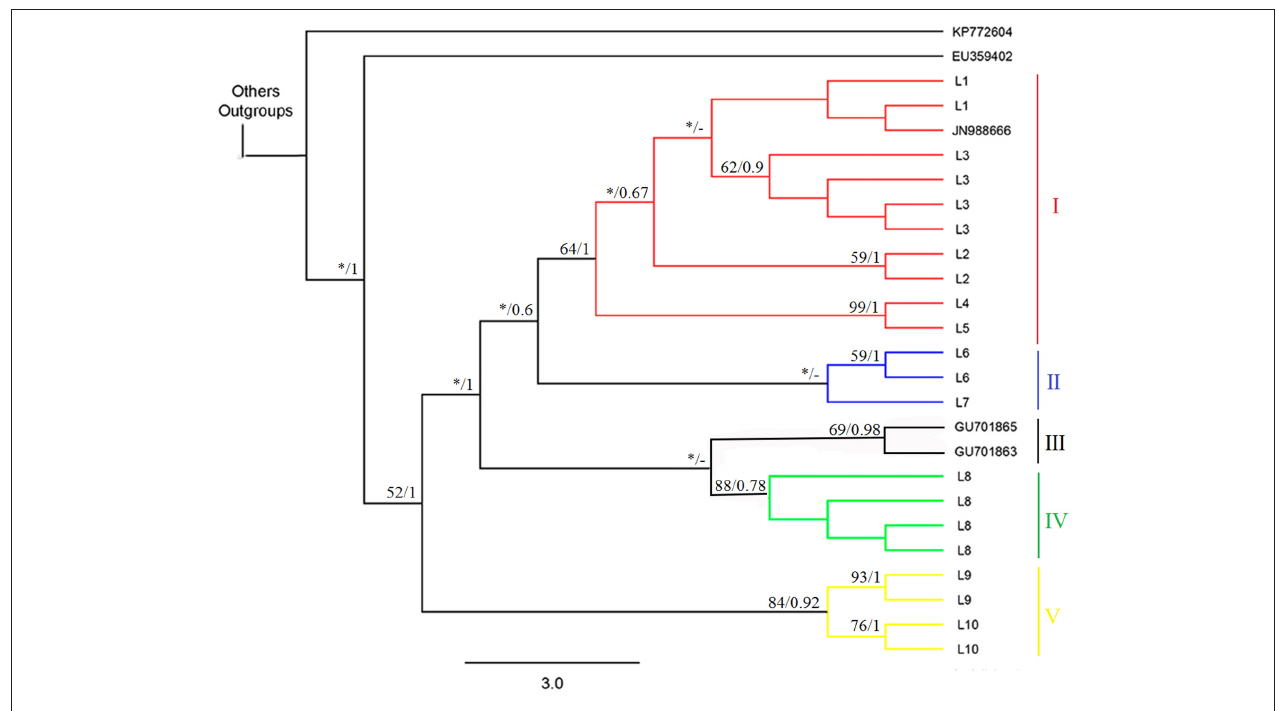
FIGURE 2 | Strict consensus cladogram produced by the Maximum Parsimony analysis showing the intrageneric relationships of the Ancistrus species from the Paraná basin, based on a 459-bp sequence of the COI gene. The numbers above the branches show the bootstrap support and Bayesian posterior probabilities, respectively. Each color represents one of the five evolutionary lineages recovered in the analysis. The terminal species with alphanumerical identifiers were obtained from GenBank (Supplementary File 1). The asterisks indicate nodes with bootstrap values of < 50. The trace indicates that the node has not been recovered by Bayesian inference. Codes: L1, Mourão River; L2, 19 Stream; L3, Keller River; L4, Patos River; L5, São João River; L6, São Francisco Verdadeiro River; L7, Arroyo Iguaçu; L8, Ancistrus cirrhosus ; L9, Ocoí River; L10, São Francisco Falso